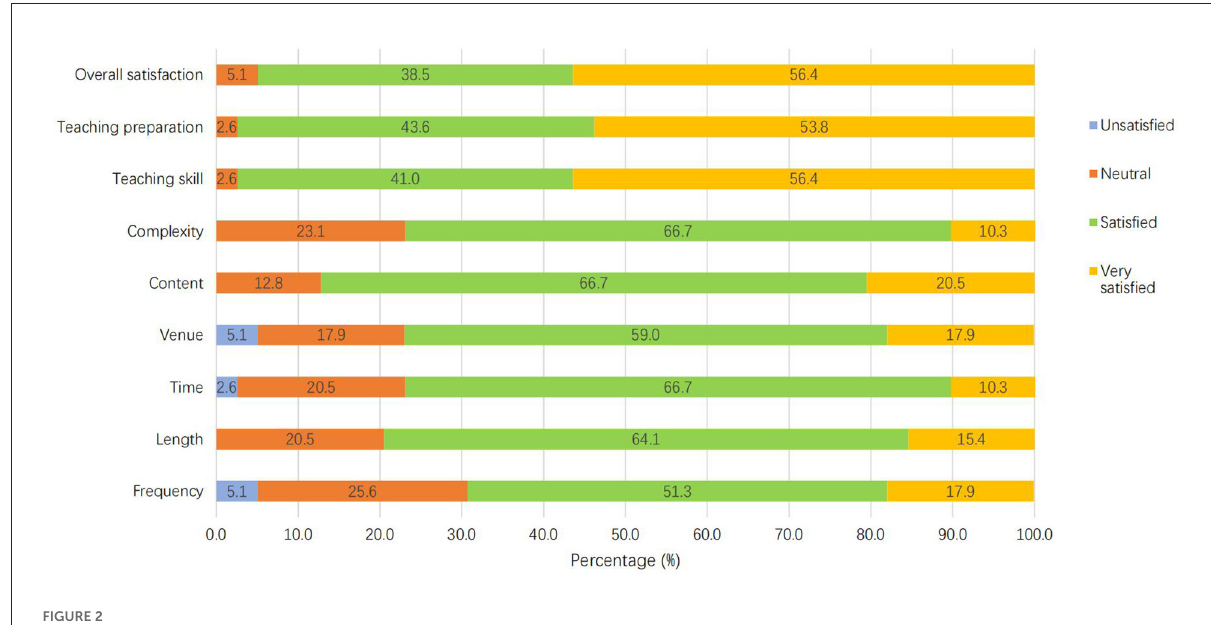
FIGURE2 Satisfactory level of the Tai Chi training.